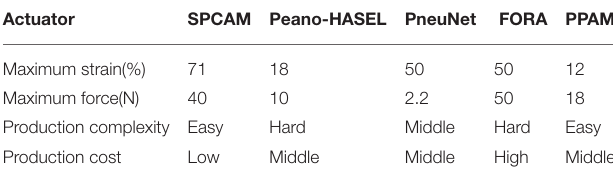
TABLE 1 | Comparison of five